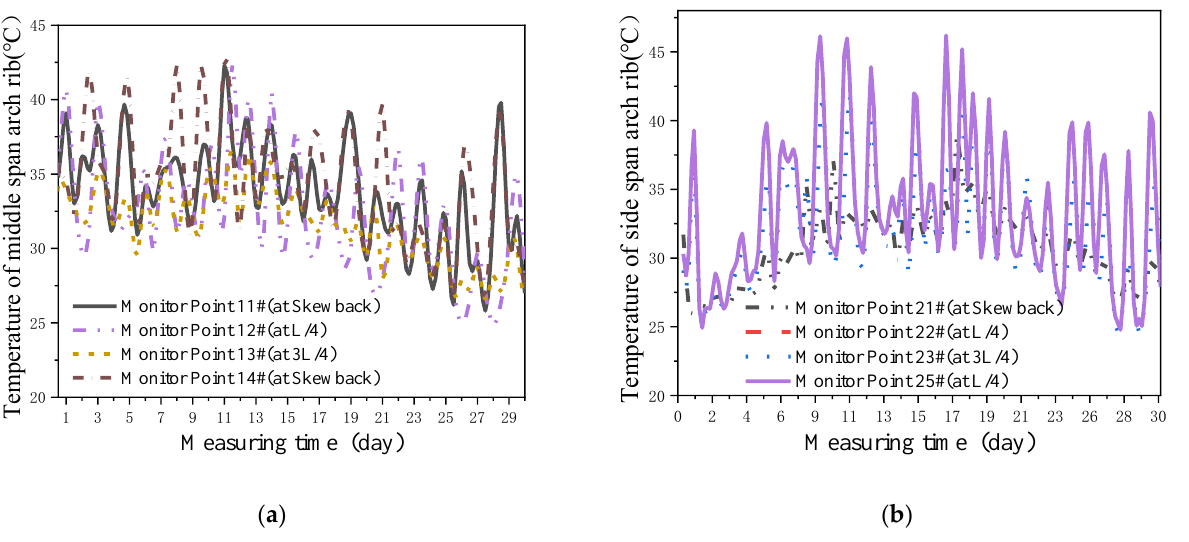
Figure 8. Monitoring results of the temperature of arch ribs: ( a ) Monitoring results of the temperature of middle span arch ribs; ( b ) Monitoring results of the temperature of side span arch ribs.